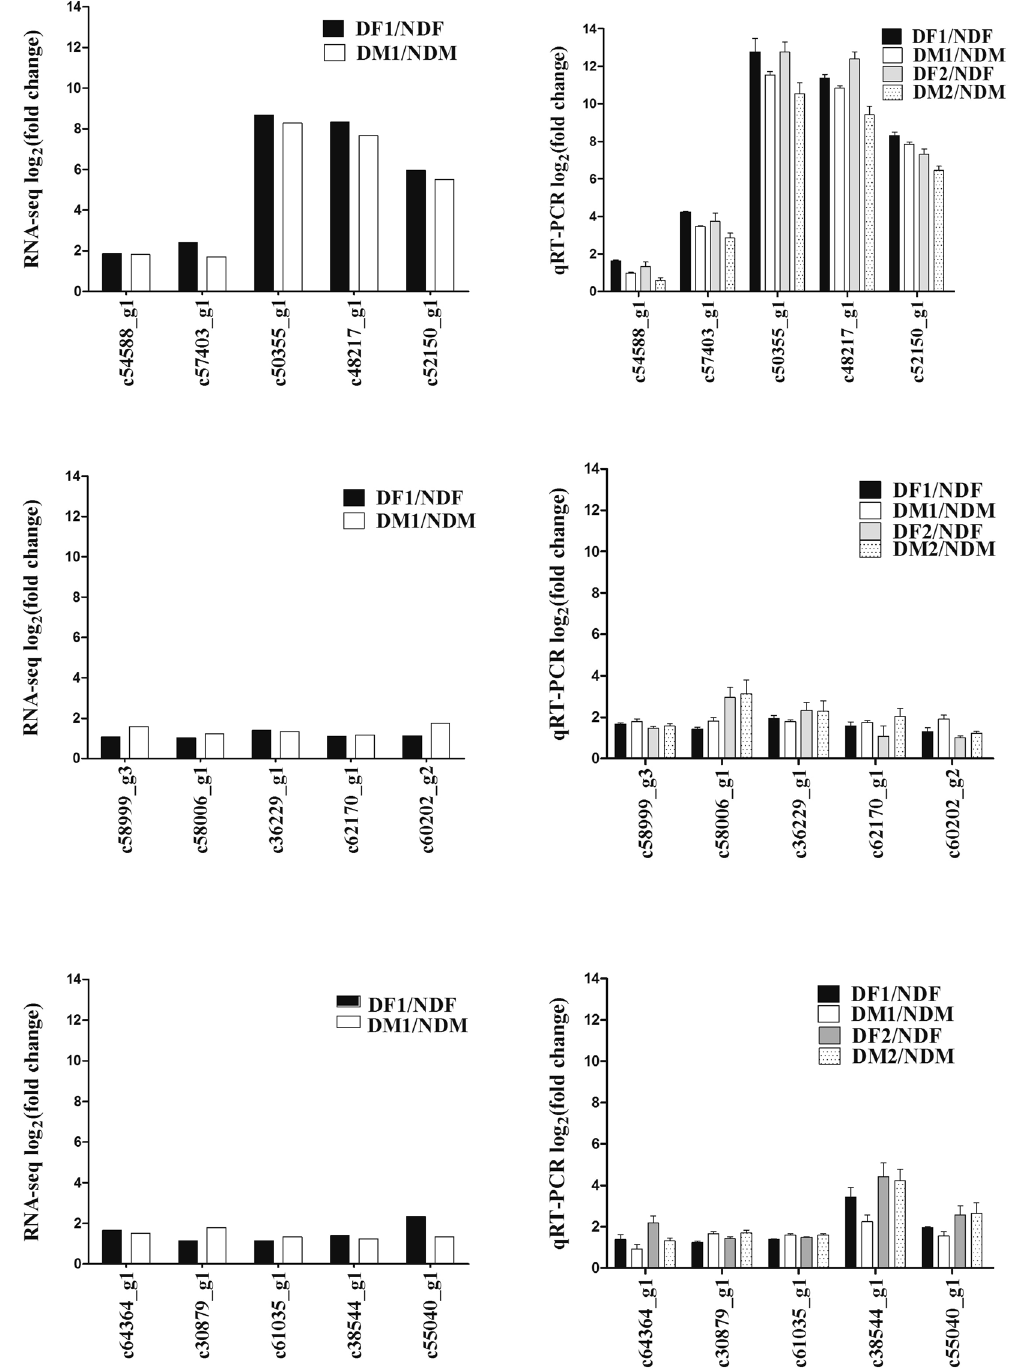
Figure 6. qRT-PCR validations of 15 DEGs during C. ciliata dormancy. The fold changes of 15 DEGs (dormant adults vs non-dormant adults) from RPKM values in RNA-Seq data and qRT-PCR data. DM1: dormant male collected in November 26, 2015(0 °C to − 8 °C), DM2: dormant male collected in January 21, 2016 ( − 15 °C to − 26 °C), NDM: non-dormant male, DF1: dormant female collected in November 26, 2015(0 °C to − 8 °C), DF2: dormant female collected in January 21, 2016 ( − 15 °C to − 26 °C), NDF: non-dormant female. The fold changes of the DEGs were calculated as the log2 value of each comparison from RNA-Seq and qRT-PCR